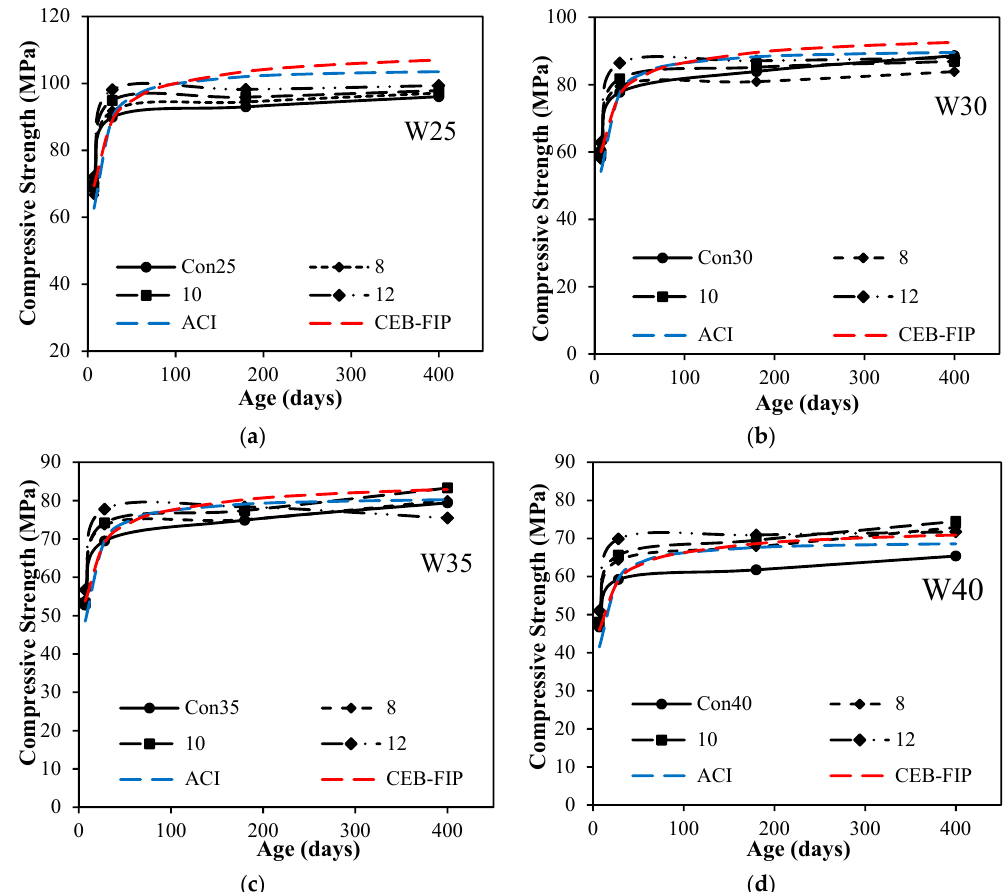
Figure 6. Compressive strength vs. age for different silica fume dosages with different w/c ratios: ( a ) compressive strength vs. age for different silica fume dosages at w/c 0.25; ( b ) compressive strength vs. age for different silica fume dosages at w/c 0.30; ( c ) compressive strength vs. age for different silica fume dosages at w/c 0.35; ( d ) compressive strength vs. age for different silica fume dosages at w/c 0.40.